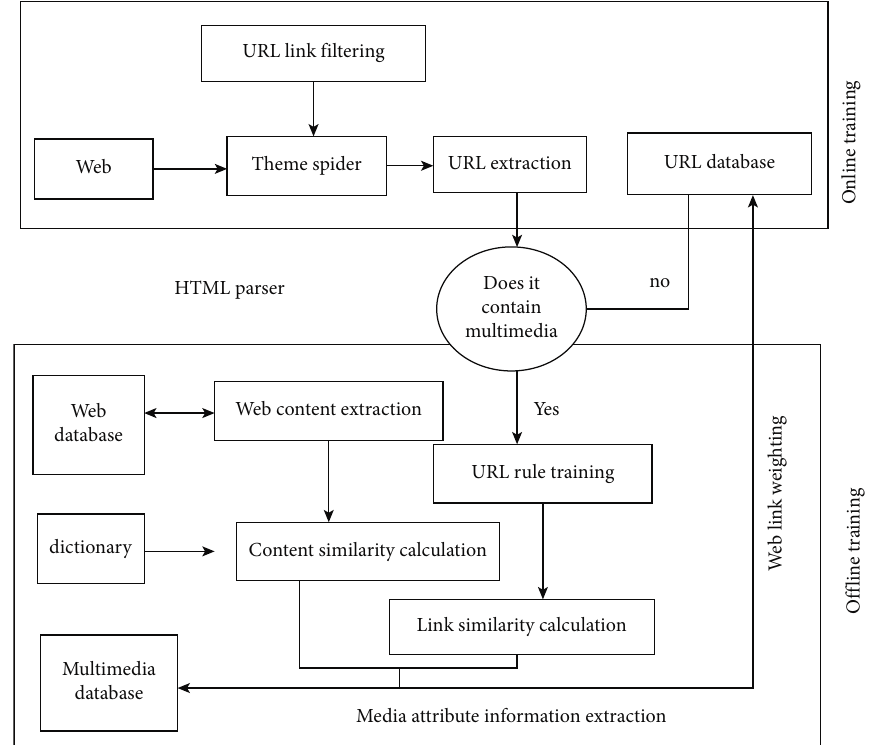
Figure 1: Network multimedia resource topic searcher